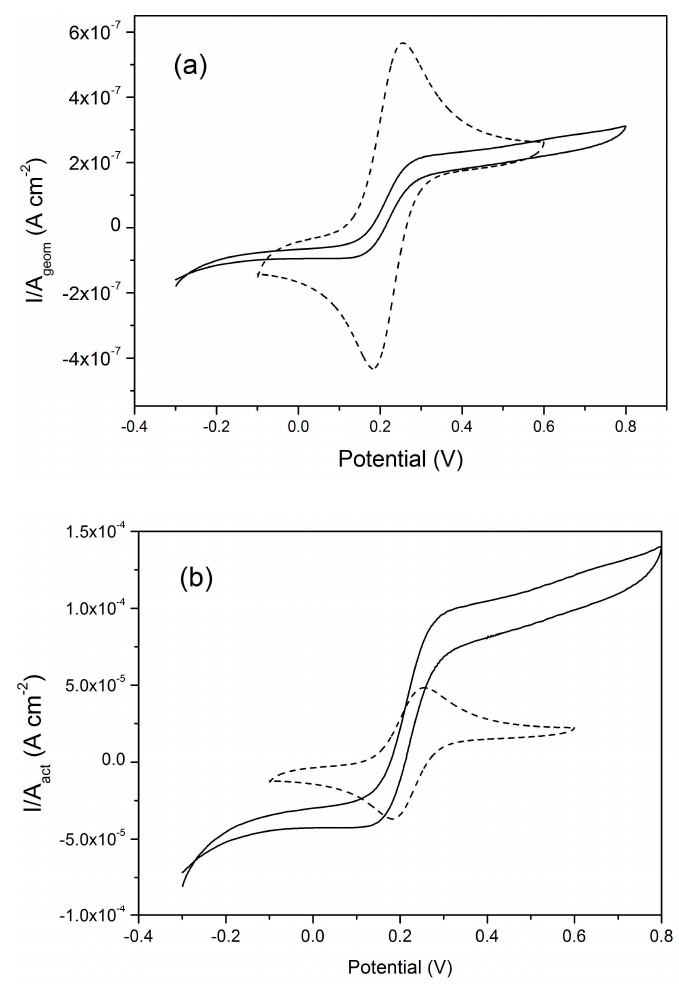
Figure 9. CVs recorded at a NEA (full line, see Figure 8) and at a NEE (dashed line, nanoelectrode radius 15 nm, A geom = 0.07 cm 2 , A act = 4.5 × 10 − 3 cm 2 ) made of Au-nanodisks in polycarbonate, plotted using current densities calculated respect to the geometric area ( a ) and active area ( b ); scan rate 10 mV · s − 1 , in 10 − 4 M ferrocenemethanol. For further details, see the original article (reprinted with